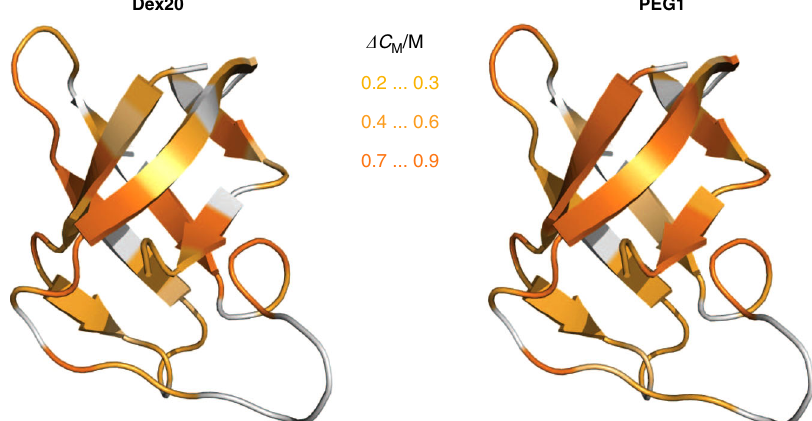
Fig. 5 Increase of thermodynamic stability of Bs CspB due to the presence of c = 120 g/L MC. The increase in the transition midpoint, Δ C M , obtained for amide protons is mapped onto the three-dimensional structure of Bs CspB (PDB ID: 1NMG) applying Dex20 (left) or PEG1 (right). The following color code has been used: 0.2 M ≤ Δ C M ≤ 0.3 M in light orange, 0.4 M ≤ Δ C M ≤ 0.6 M in orange and 0.7 M ≤ Δ C M ≤ 0.9 M in bright orange whereas residues colored in gray report on lack of experimental data. Numerical values for Δ C M obtained under these experimental conditions can be found in Fig. 2c, d and Supplementary Table